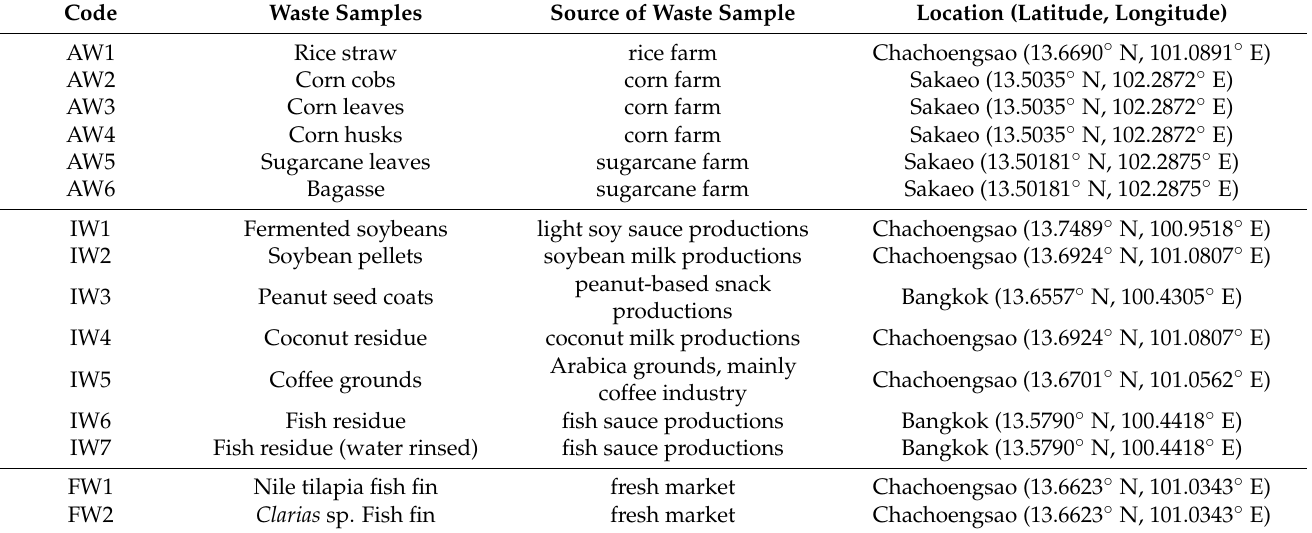
Table 4. Waste sample characteristics; AW, agricultural waste; IW, agro-industrial waste; FW, fishery